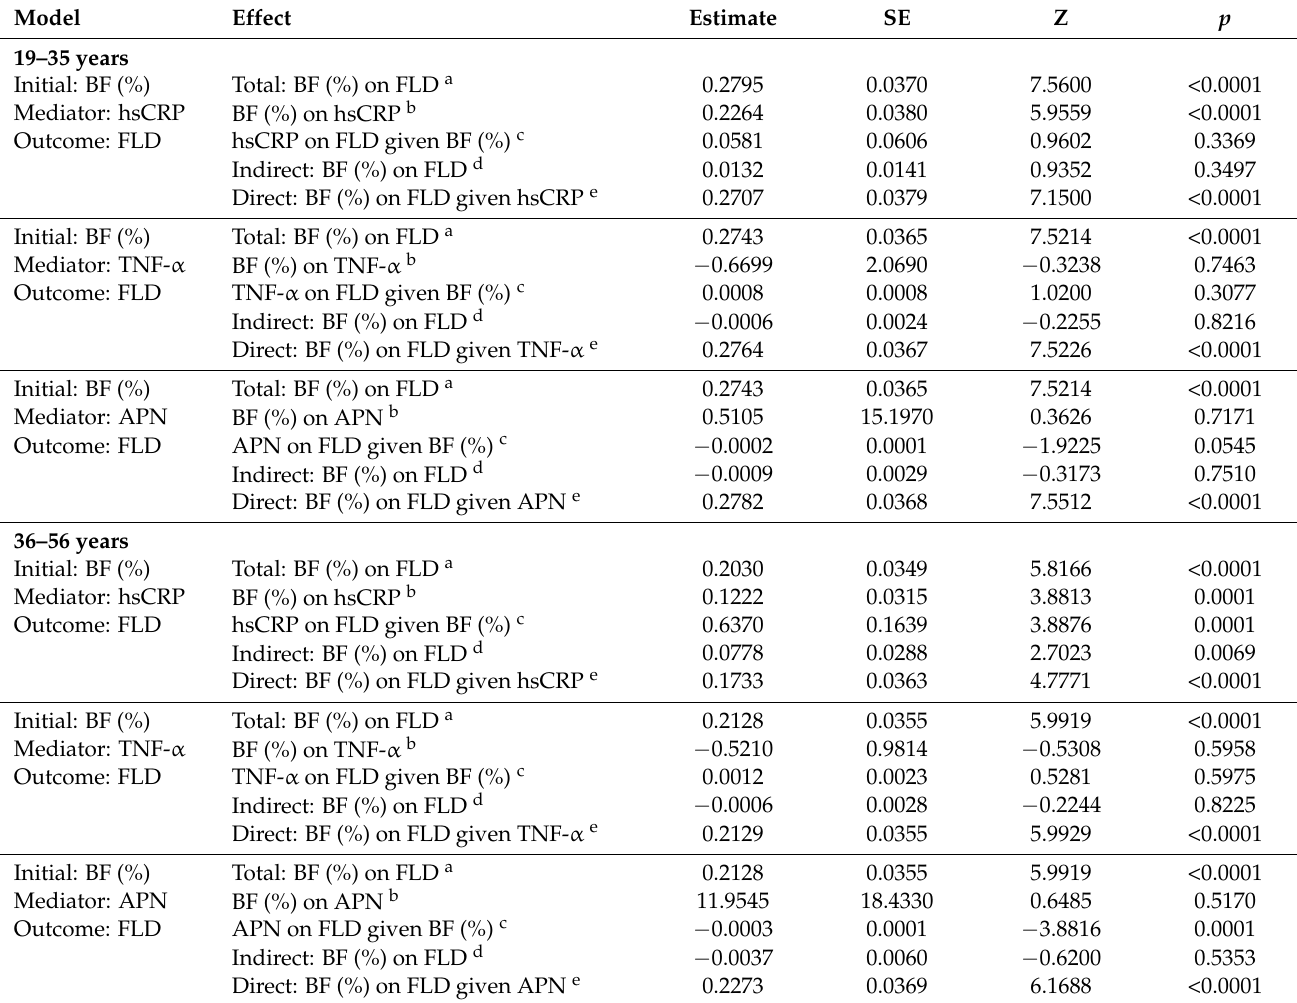
Table 3. Results of Mediation Analysis stratified by age